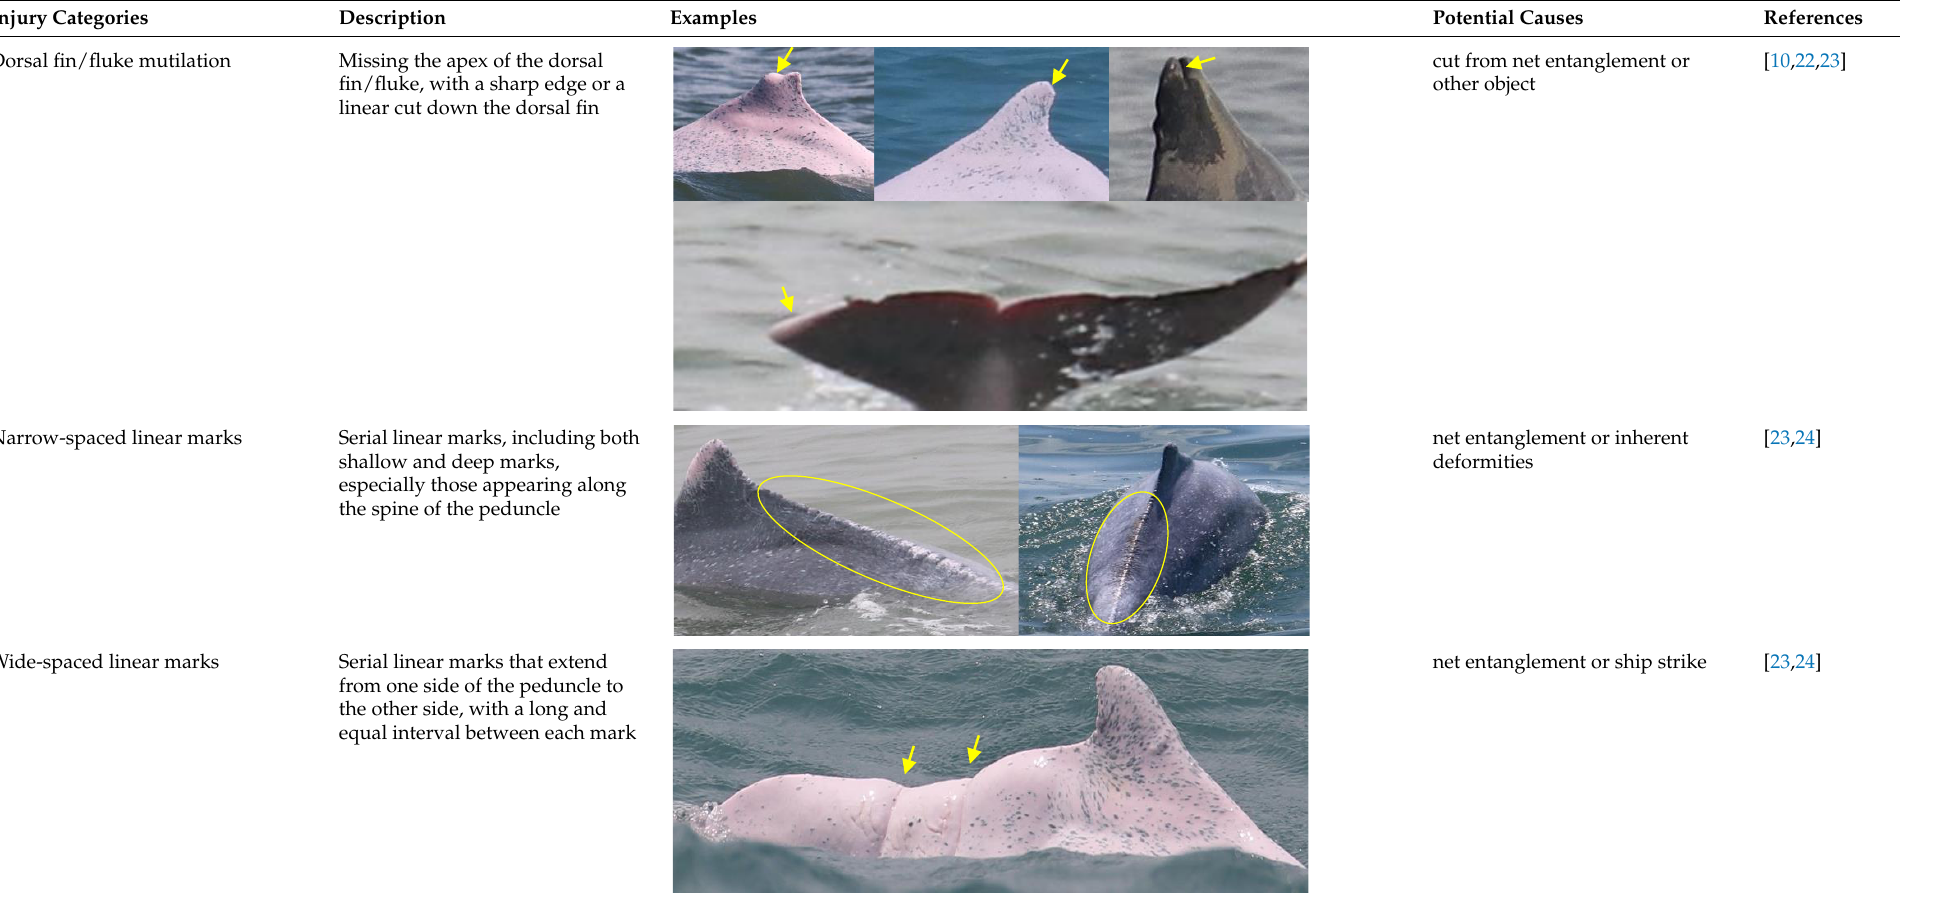
Table 1. Definitions of injury (arrows and circles) categories and potential causes.